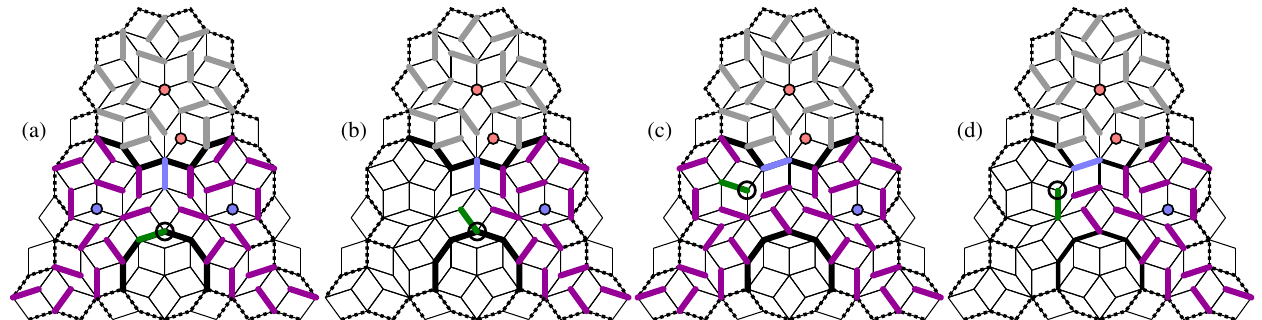
FIG. 21. Proof that, of the edges emanating from a 6-vertex, only the edges indicated in Fig. 6(b) may host dimers. See accompanying text in Appendix A 2.